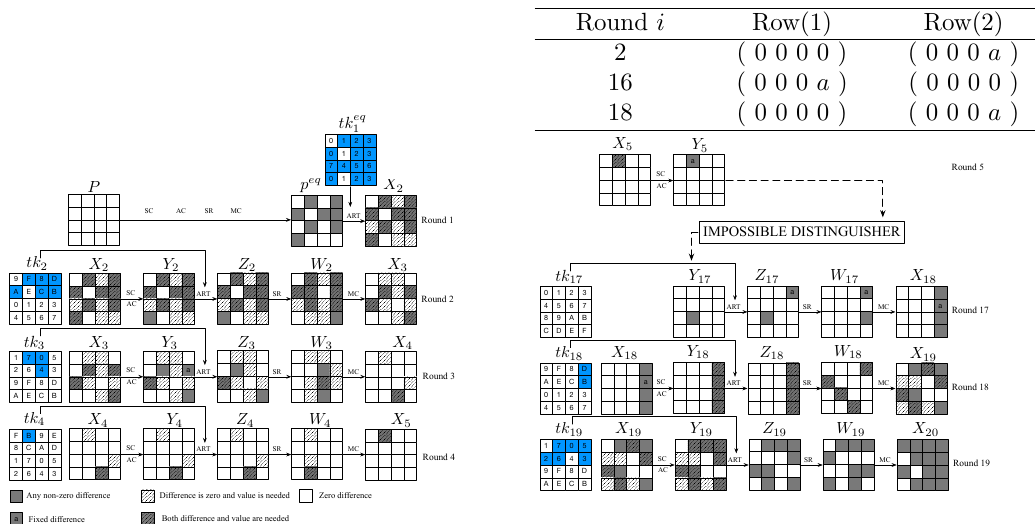
Figure 11: 19-round attack against SKINNY- n - n